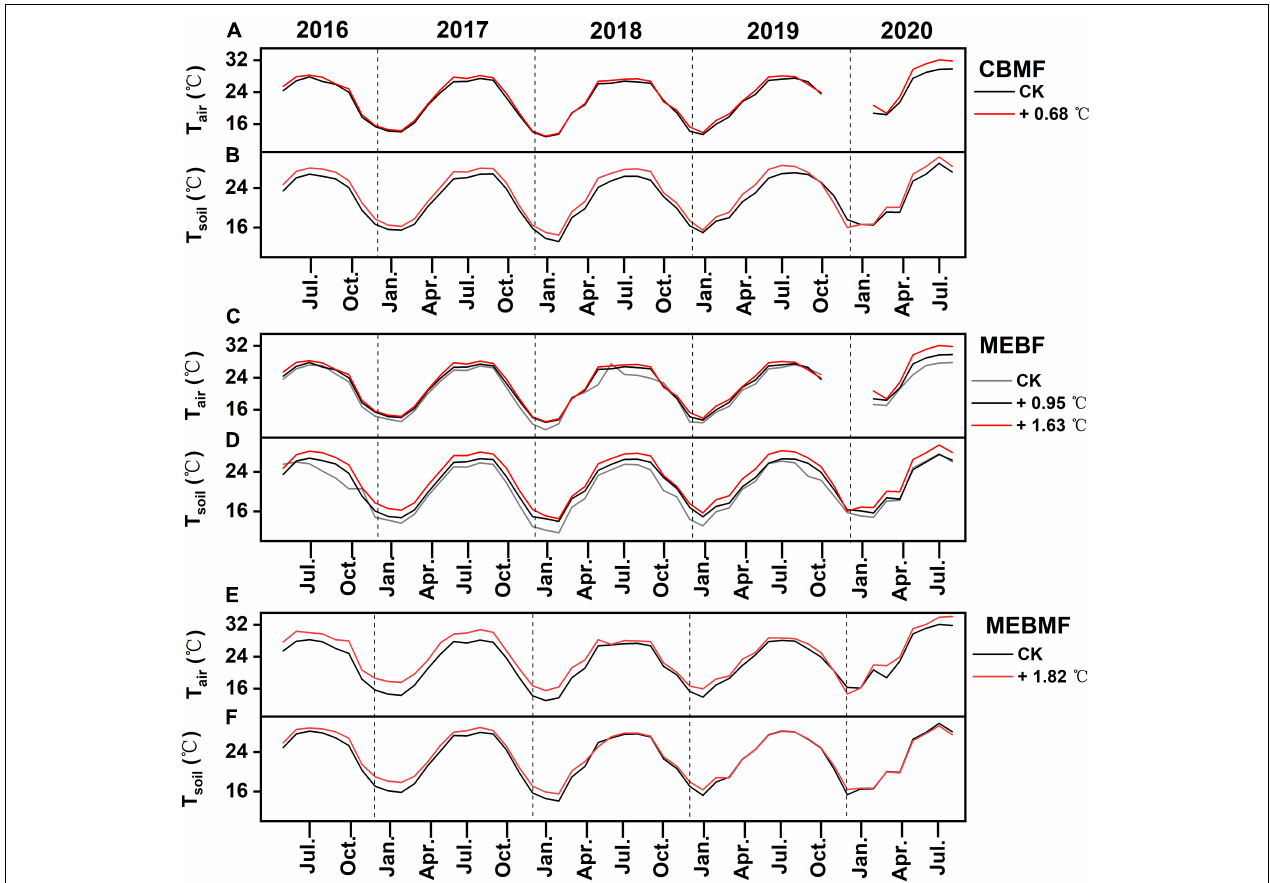
FIGURE 2 | Monthly mean air temperature (T air , ◦ C) and monthly mean soil temperature (T soil , ◦ C) at (A,B) coniferous and broadleaf mixed forest (CBMF), (C,D) mountain evergreen broadleaf forest (MEBF) and (E,F) monsoon evergreen broadleaf forest (MEBMF) from 2015 to 2020.